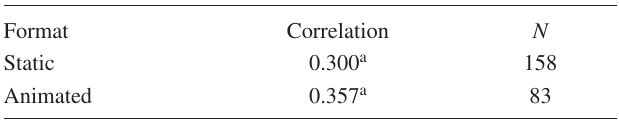
TABLE III. Correlation coefficients between math ACT score and FCI